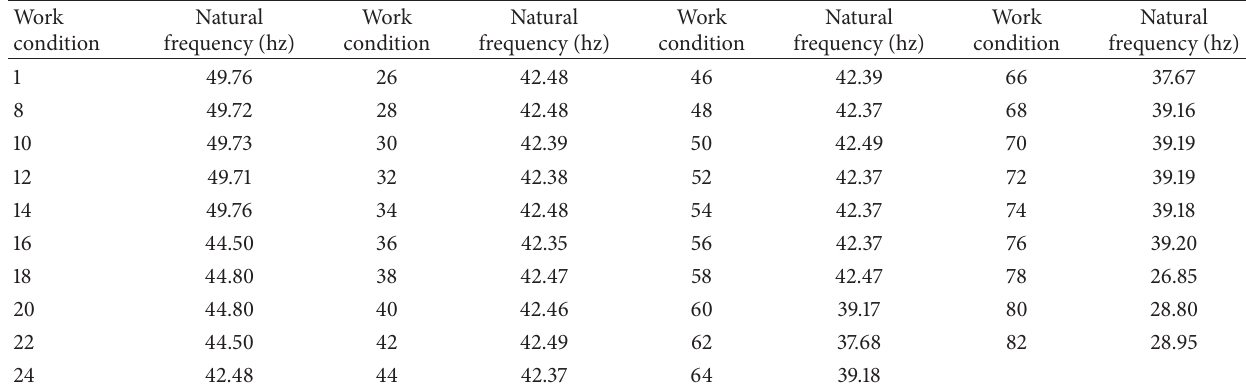
Table 6: Natural vibration frequency of the specimen.